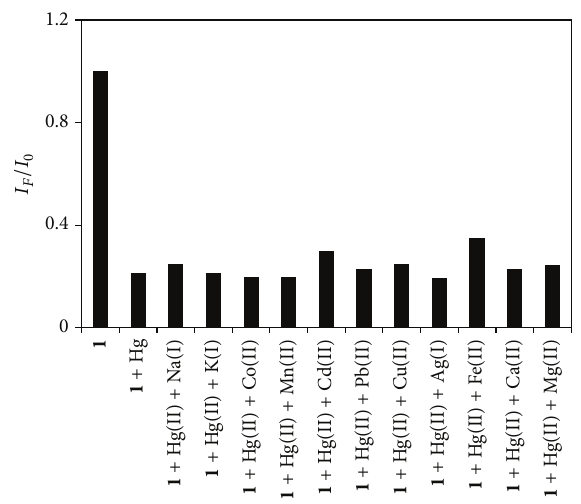
Figure 8: 𝐼 𝐹 /𝐼 0 (where 𝐼 0 was the initial fluorescence emission signal and 𝐼 𝐹 was the fluorescence emission) in the 1 -Hg 2+ system containing [1] = 0.15 𝜇 M, [Hg 2+ ] = 9 𝜇 M and [M 𝑛+ ] = 90 𝜇 M in CH 3 CN.